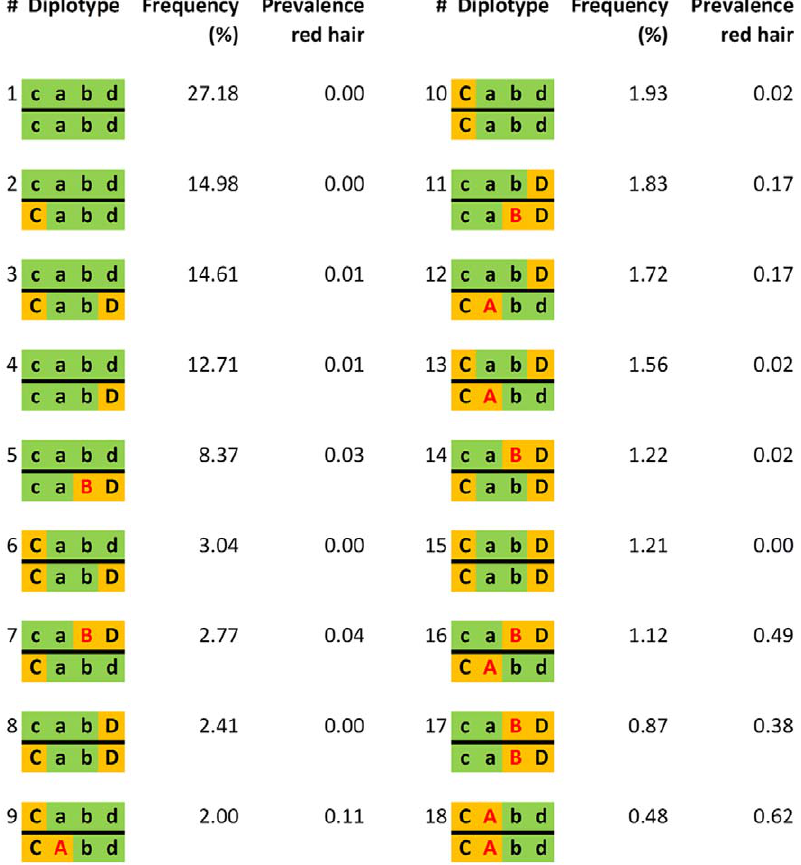
Figure 6. Frequency of diplotypes and the prevalence of red hair in the Rotterdam Study. The causal SNP a is rs1805007 and b is rs1805008. The tagging SNP c is rs2011877 and d is rs2302898. Causal alleles A and B are indicated in red color. Common alleles are indicated in green background and minor alleles are indicated in orange background.